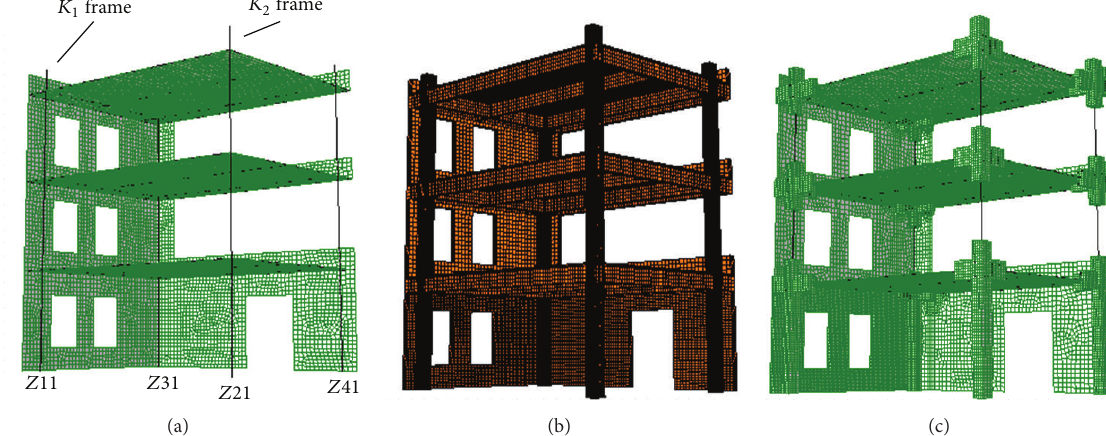
Figure 7: Numerical computational model: (a) macro-scale FEM; (b) micro-scale FEM; (c) element-coupling model.